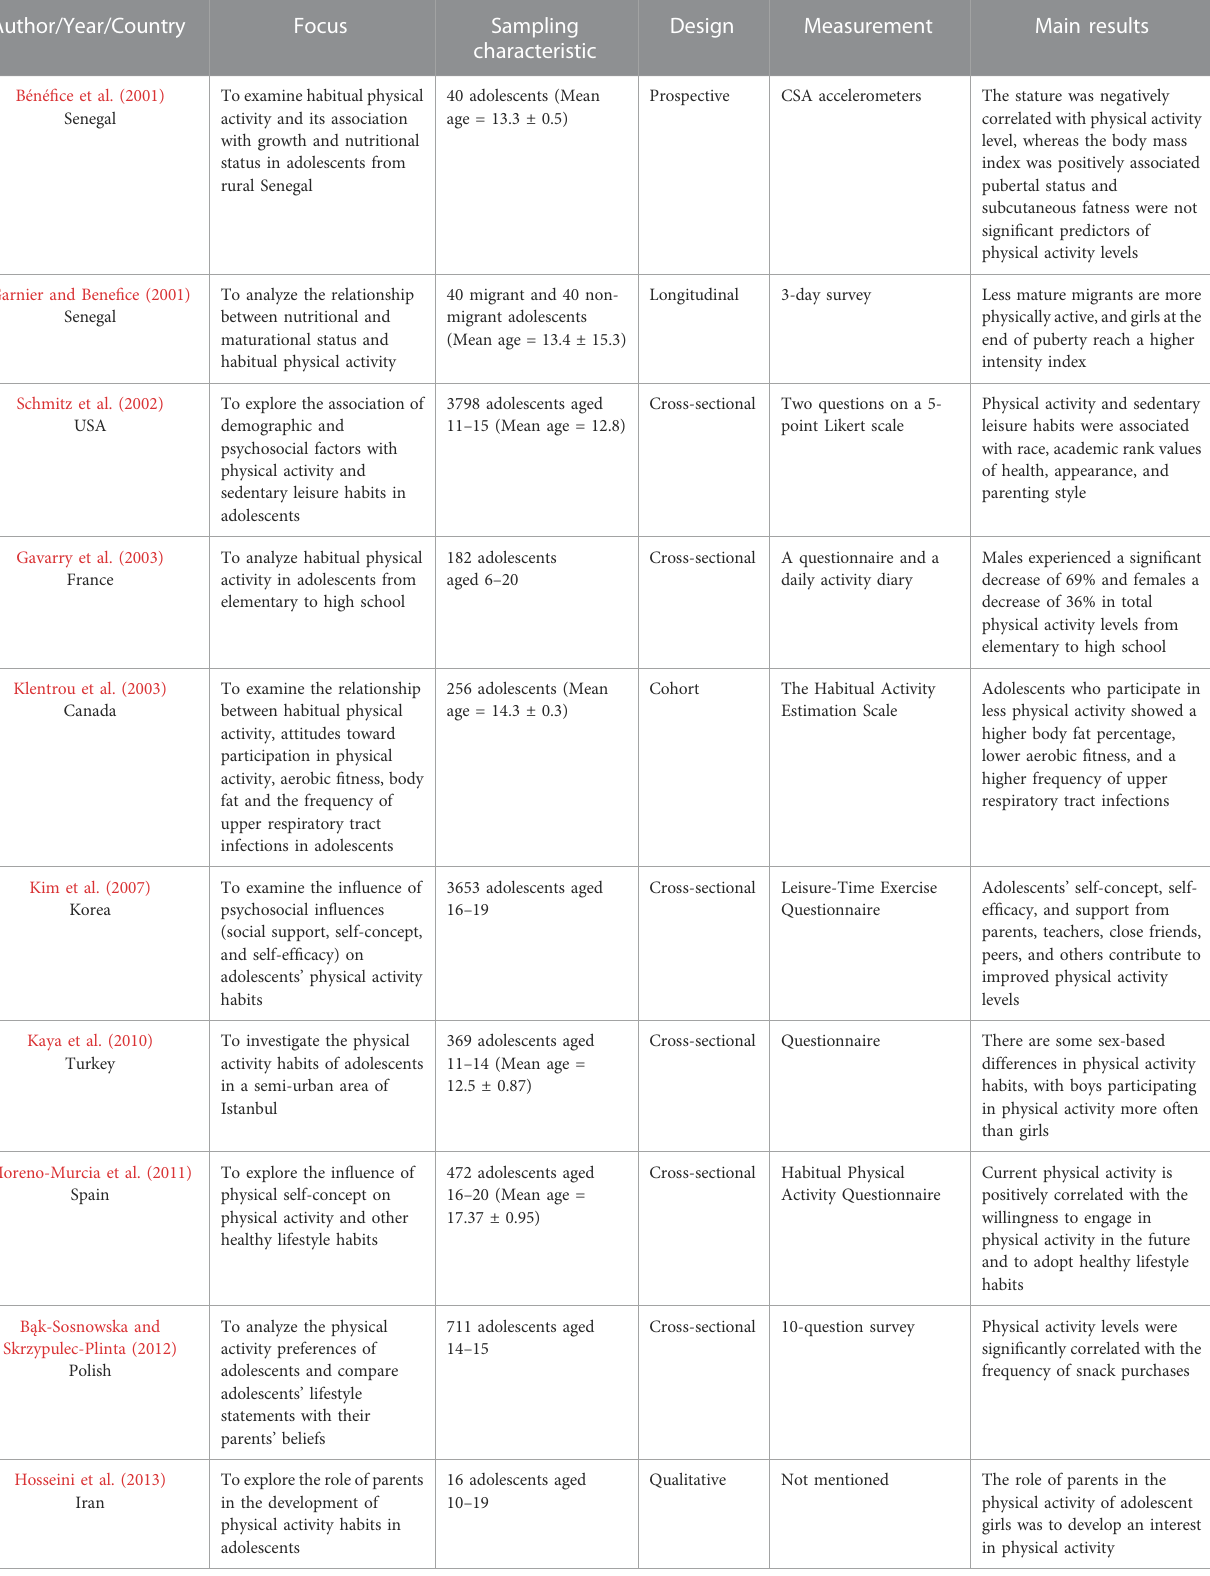
TABLE 1 Characteristics of the included